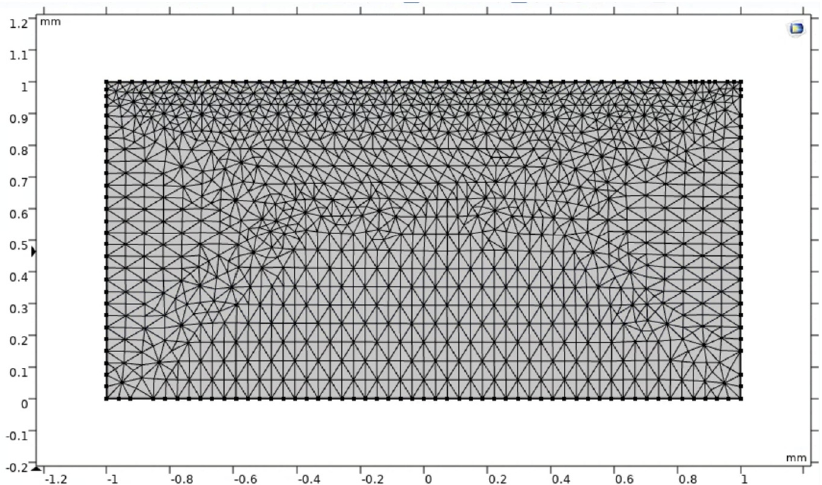
Figure 7. COMSOL model initial mesh including increased density near the surface due to modeled adsorptive surface phenomena.